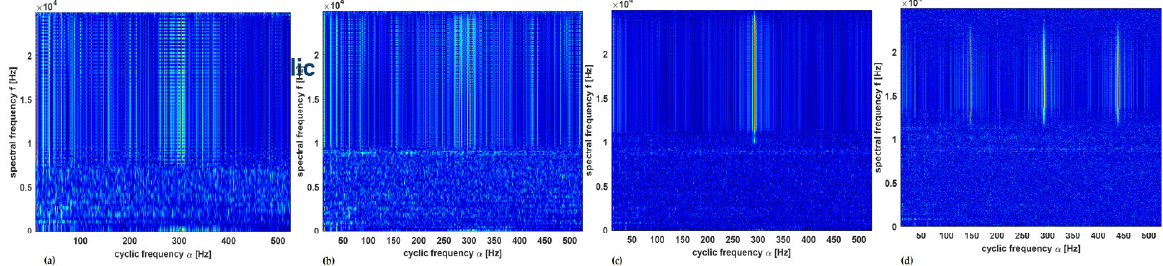
Figure 7. Cyclic spectral coherence maps for healthy shaft at window size: ( a ) 128, ( b ) 256, ( c ) 512, and ( d ) 1024.